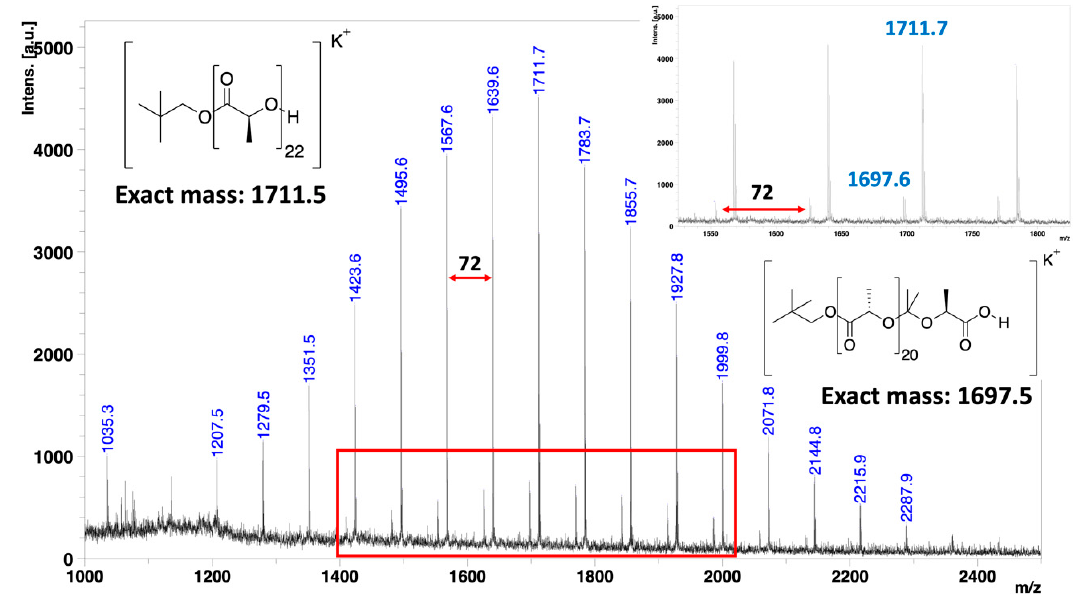
Figure 6. MALDI-ToF spectrum of the product with magnification and related structures.